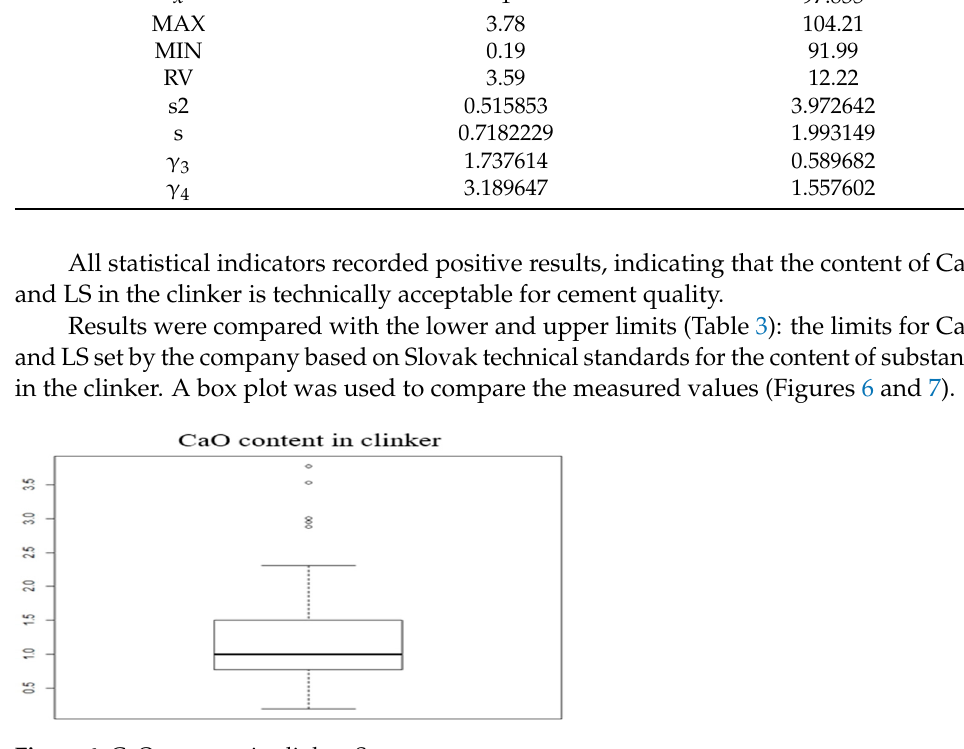
Figure 7. LS content in clinker. Source: own source. In conclusion, the content of CaO F in the clinker was outside the limits at values of 2.07, 2.95, 2.88, and 3.53. More CaO F in the clinker can affect the cement quality. The LS clinker carbonation values should be within the limit of 95–100; however, we found that seven data did not correspond to the limit and were in the range of 100.4 to 103. Based on the economic analysis of failure findings in a sample of CaO F and LS in the clinker, the main proportions of findings above and below the limit were determined. The economic analysis of CaO F and LS substances in clinker was performed using Formula (1). The results of the economic analysis are presented in Table 6. Based on the results, we can see that the components of CAO F and LS in the clinker samples were also failures of sam- ples, which can have consequences for the formation of the cement and affect its quality. More failures of the samples were over the limit. Table 6. Economic analysis—index of failures for CaO F , LS. Source: own source. Failures CaO F